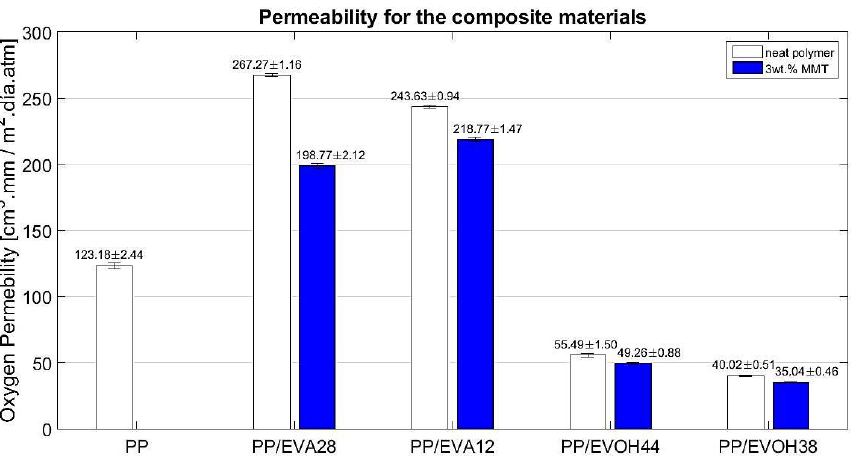
Figure 4. Oxygen permeability for the neat PP, polymeric blends PP/EVA and PP/EVOH and nanocomposite materials made of the different kinds of copolymers.